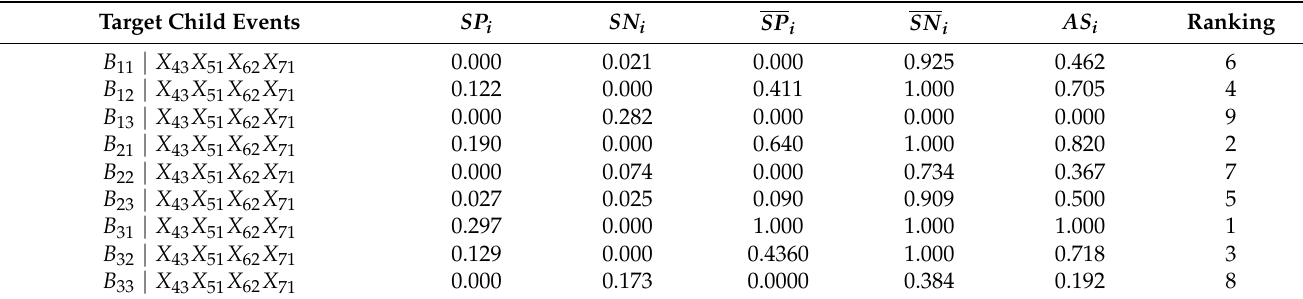
Table 5. The computation results by the EDAS method.